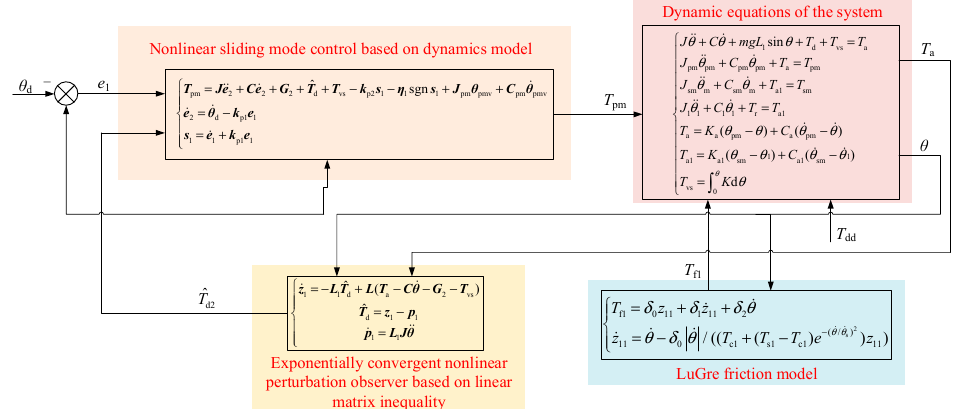
Figure 6. Sliding mode control strategy based on nonlinear disturbance observer and dynamics model.